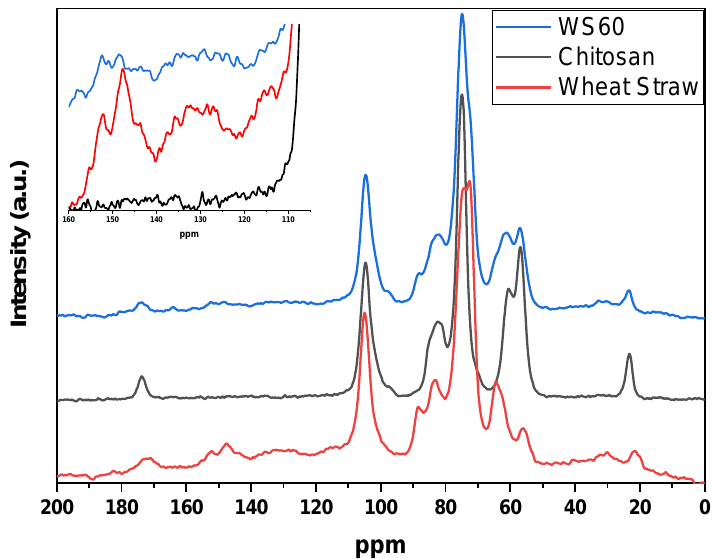
Figure 2. 13 C solids NMR spectra of chitosan, torrefied wheat straw and the WS60 pellet material, where the inset shows an expansion of the 160–110 ppm spectral range.